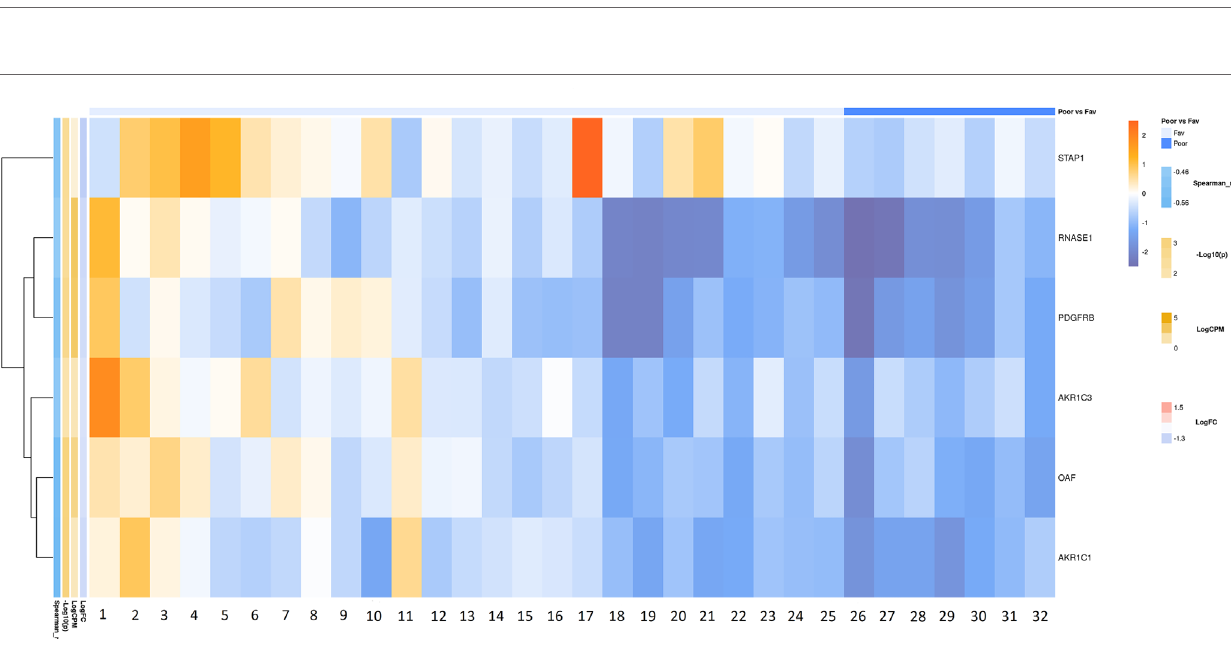
FIGURE 7 | Heatmap demonstrating log relative expression level of top differentially expressed genes between the groups of adverse and favorable prognosis (Russian patient cohort). Cell colors (blue-white-orange gradient) correspond the binary logarithm of the ratio of the expression level in a current sample to the average level across all the samples (per each gene). Blue - expression level is below the average, orange - above the average. Spearman_r—Spearman’s rank correlation coefficient. -Log10(p) is the negative logarithm of DESeq’s p -value. LogCPM—average binary logarithm of read counts per million (CPM). LogFC—binary logarithm of expression-level fold change (sample with adverse prognosis compared to favorable prognosis).